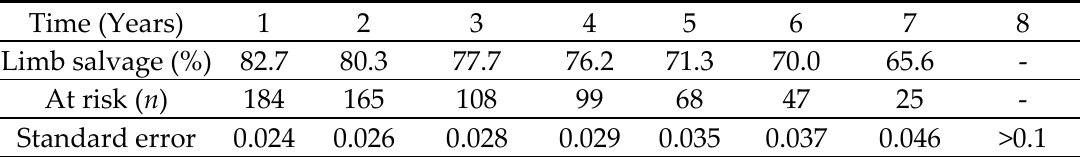
Figure 2. Comparison of the limb salvage rates depending on different bypass materials (log-rank p < 0.001).